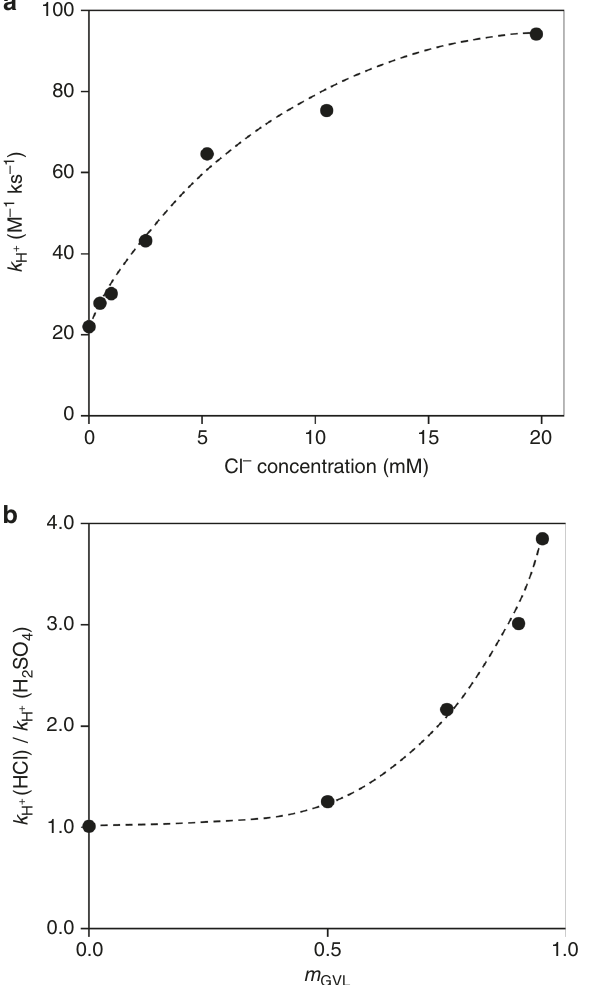
Fig. 1 Fructose conversion rate constant versus Cl − and GVL concentrations. a Fructose conversion rate constant values in 90% GVL/ 10% H 2 O with varying Cl − concentration using tri fl ic acid (5 mM acid) and ( b ) ratio of fructose conversion rate constant values for fructose conversion into HMF for HCl and H 2 SO 4 (equimolar catalyst concentrations) with varying GVL solvent concentration (mass fraction with H 2 O). Black dashed lines represent visual guides. Reaction conditions: fructose (50 mM); acid (Fig. 1a: 5 mM; Fig. 1b: 5 mM – 0.5 M), 373 K; solvent (5 mL); stirring (700 rpm). Reaction rate constant values: r = k H + [R] [H +